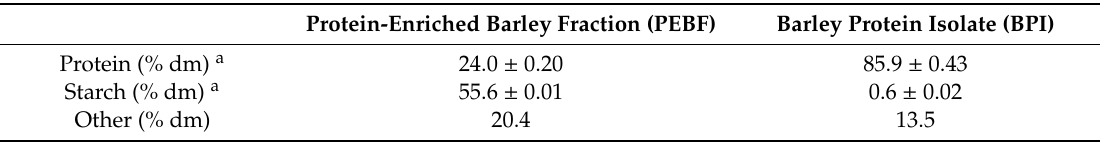
Table 1. Protein and starch content in the protein-enriched barley fraction (PEBF) and barley protein isolate (BPI).